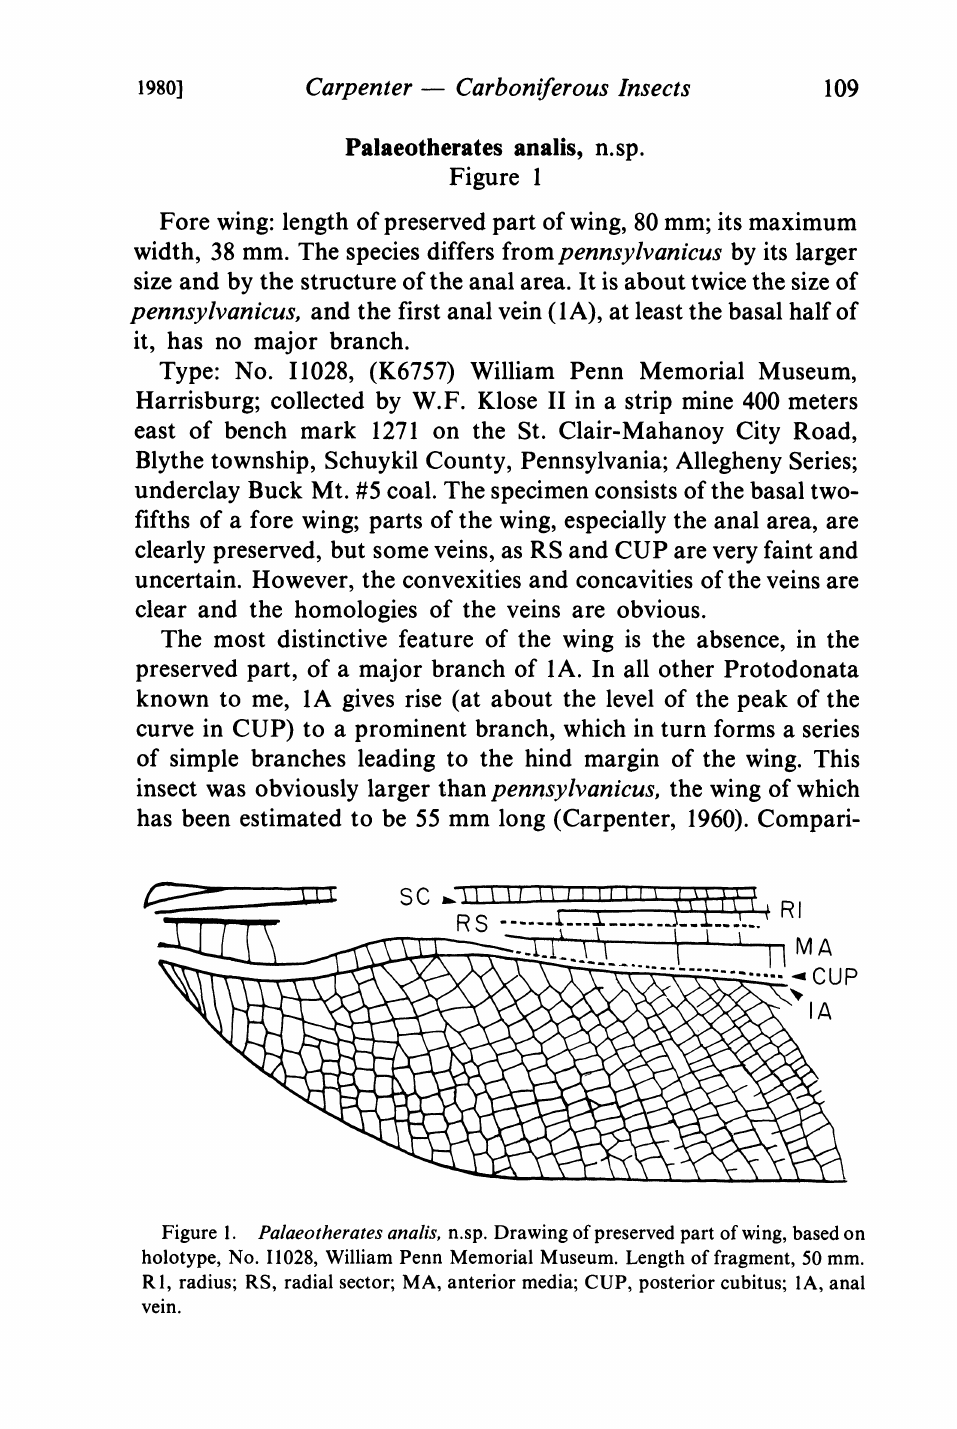
Figure 1. Palaeotherates analis, n.sp. Drawing of preserved part of wing, based on holotype, No. 11028, William Penn Memorial Museum. Length of fragment, 50 mm. R 1, radius; RS, radial sector; MA, anterior media; CUP, posterior cubitus; 1A, anal